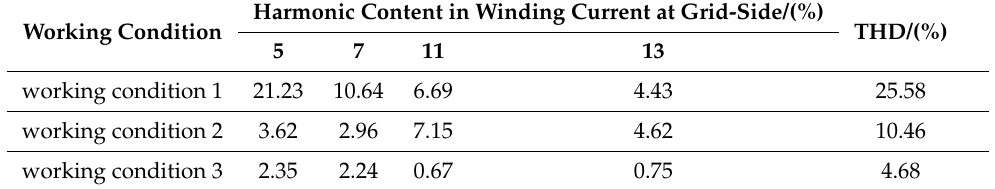
Table 4. Harmonic content in measured current at grid-side winding of the inductive filter converter transformer under three working